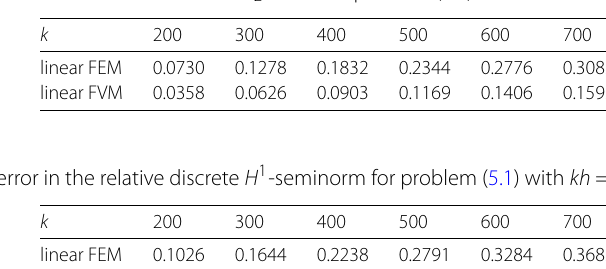
Table 7 The error in the relative discrete L 2 -norm for problem (5.1) with kh = 0.125